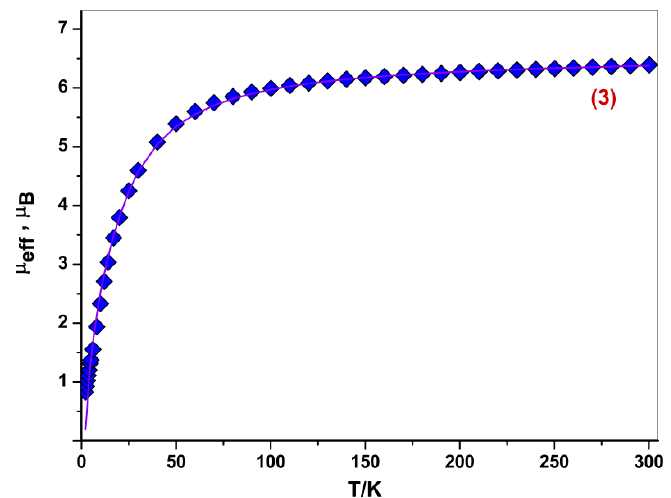
Figure 5. The temperature dependence of the effective magnetic moment μ eff (T) for complex 3 . Solid line is a theoretical curve.